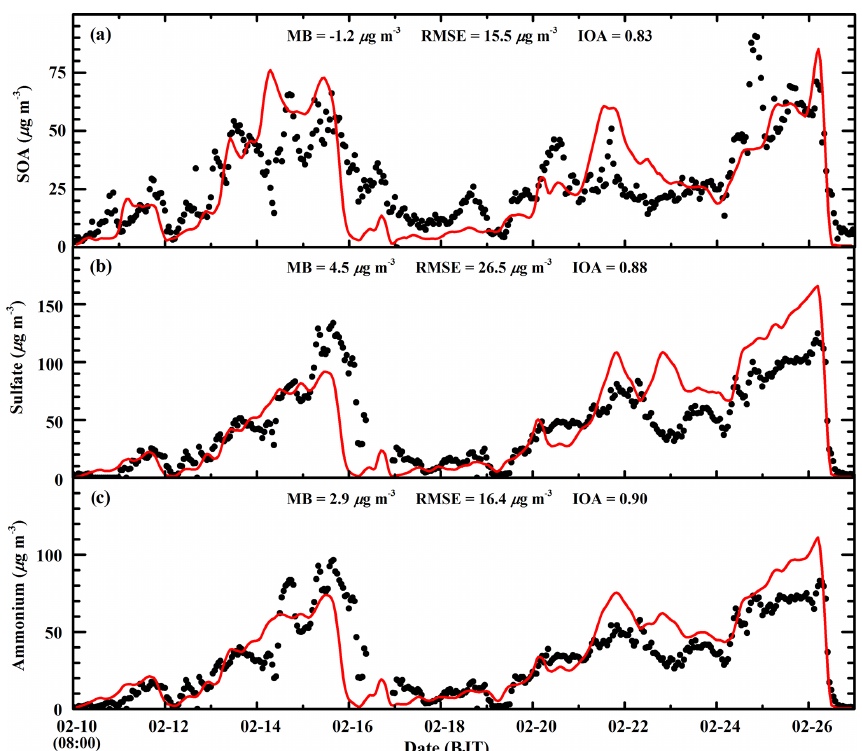
Figure 7. Comparison of observed (black dots) and simulated (red line) diurnal profiles of hourly (a) SOA, (b) sulfate, and (c) ammonium concentrations at the CRAES site in Beijing from 10 to 27 February 2014.